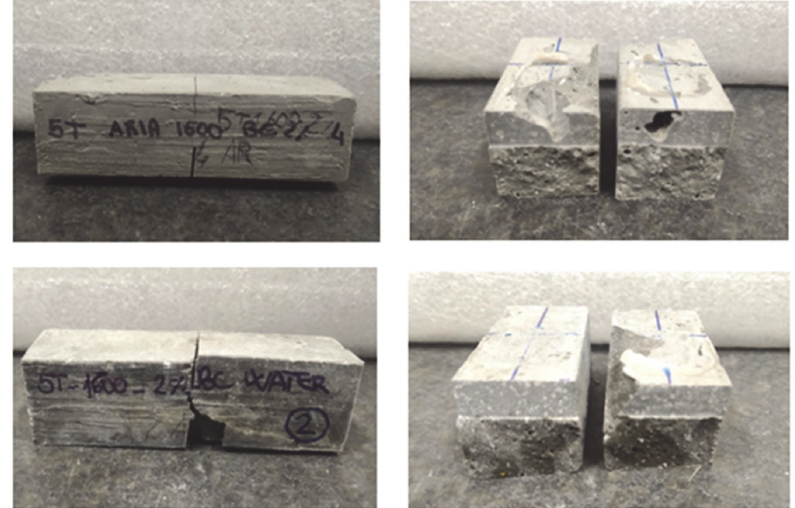
Figure 7: Fracture path and fracture surface of four analyzed foamed concrete notched beams with 2% biochar cured in air (top) and in water (bottom).